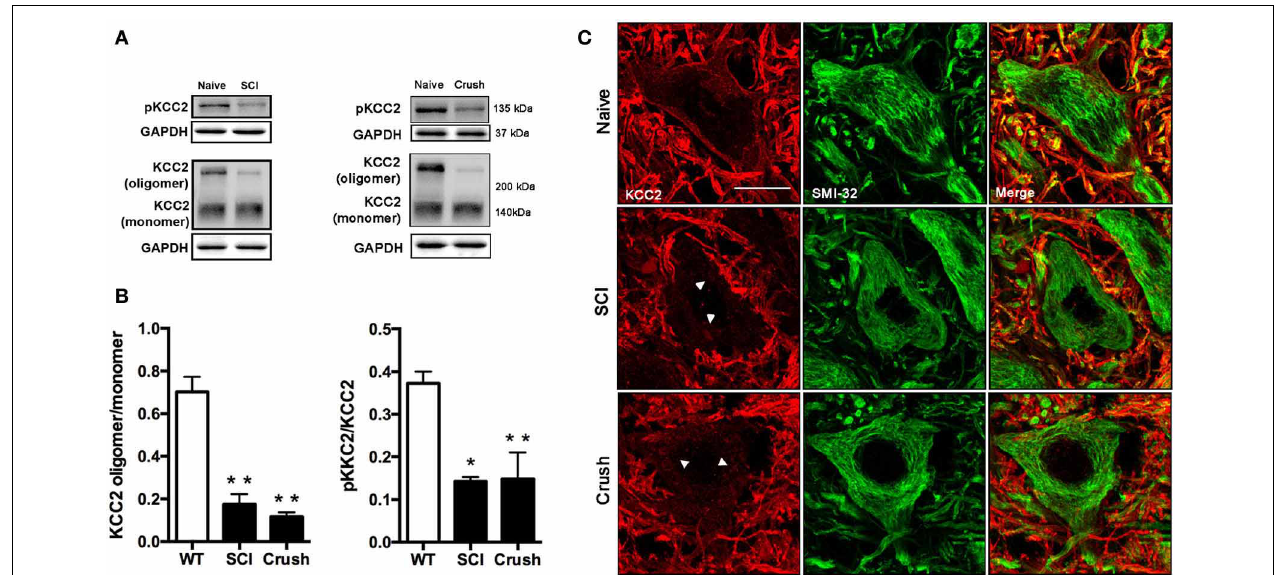
FIGURE 4 | Analysis of KCC2 and phopho-KCC2 expression in the ventral spinal cord of SCI and sciatic nerve injured mice. (A) Representative blots of phopho-KCC2 and total KCC2 (on both monomeric and oligomeric states) in SCI and crush mice. (B) KCC2 western blots quantifications. Graphs represent the ratio between the oligomeric KCC2 (functional state) vs. monomeric KCC2 and the phopho-KCC2 (active form) vs. monomeric KCC2. Both analyses